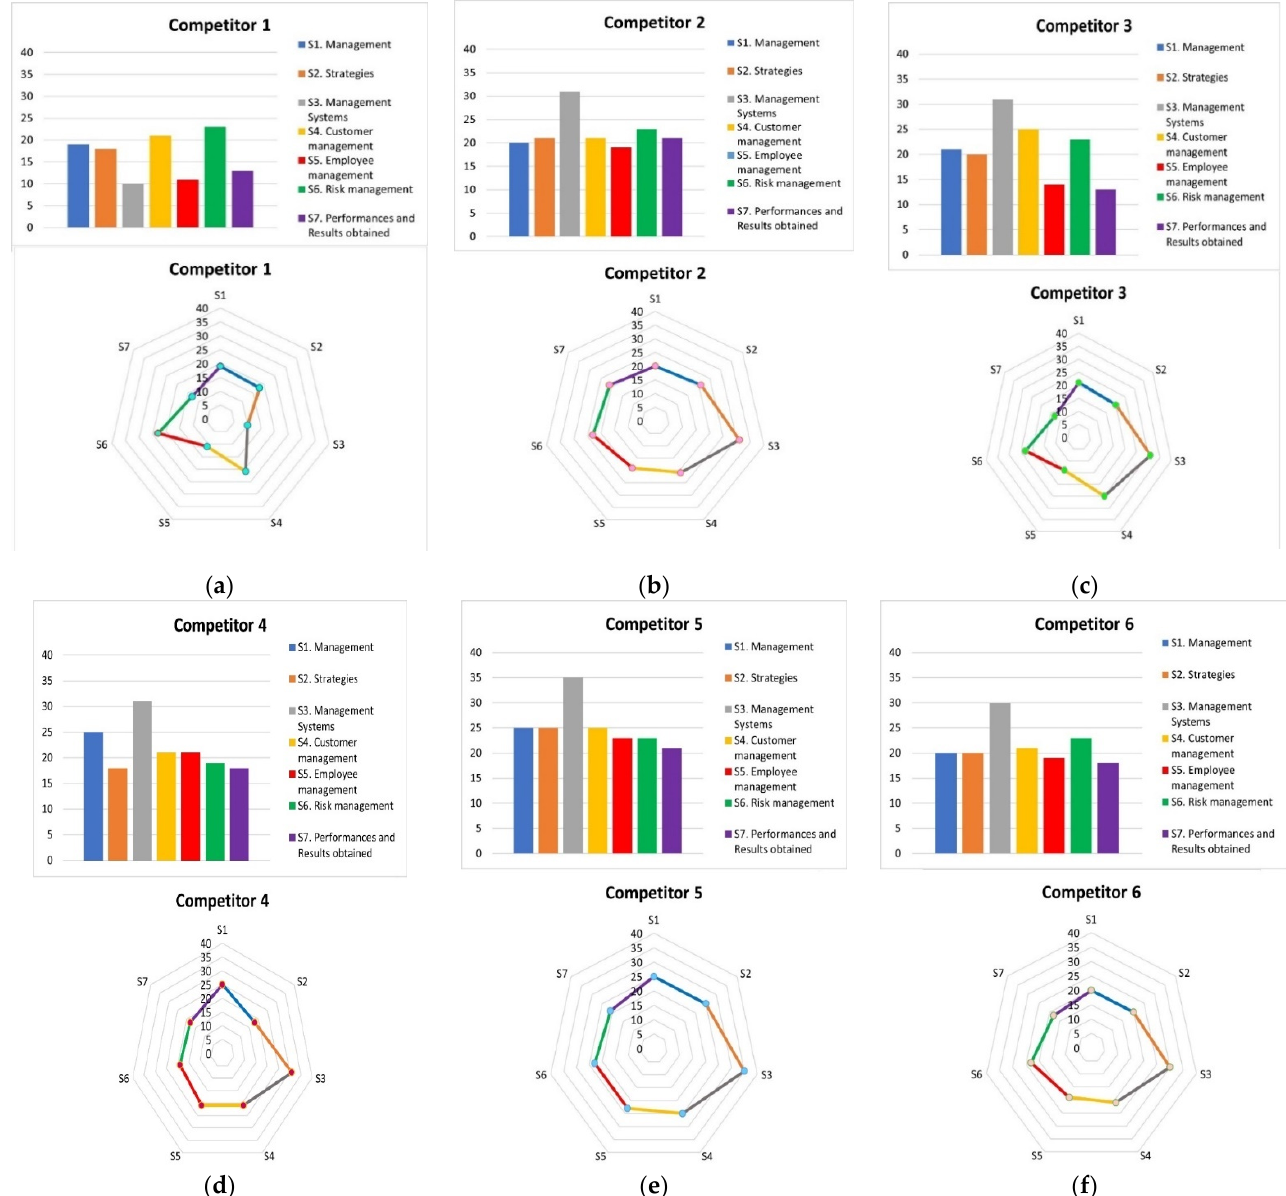
Figure 7. ( a ) Competitor 1 individual scores; ( b ) Competitor 2 individual scores; ( c ) Competitor 3 individual scores; ( d ) Competitor 4 individual scores; ( e ) Competitor 5 individual scores; ( f ) Competitor 6 individual scores;.